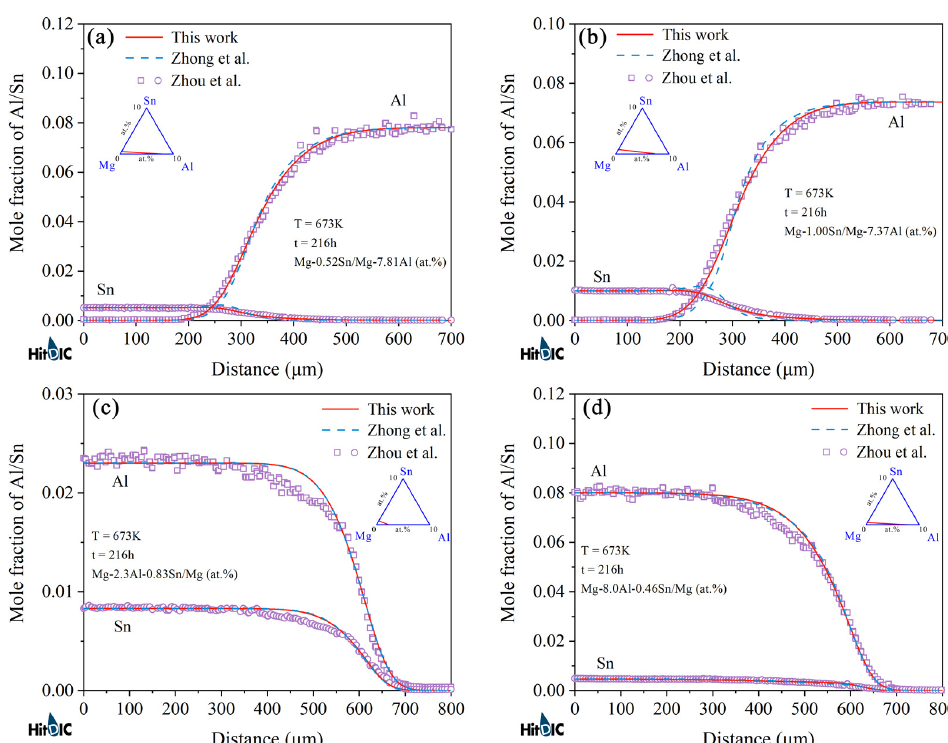
Figure 6. ( a – d ) Model-predicted composition–distance profiles of the different hcp Mg–Al–Sn diffusion couples annealed at 673 K for 216 h from the present atomic mobilities (solid lines) compared with those of Zhong et al. [32] (dashed lines) and the experimental data [37] (in symbols).